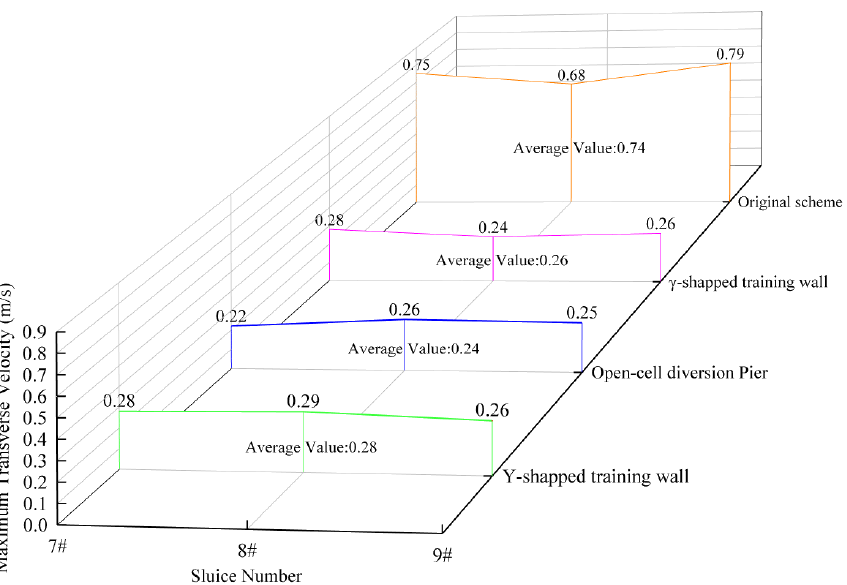
Figure 18. Comparison of rectification effects of various schemes (operational state of